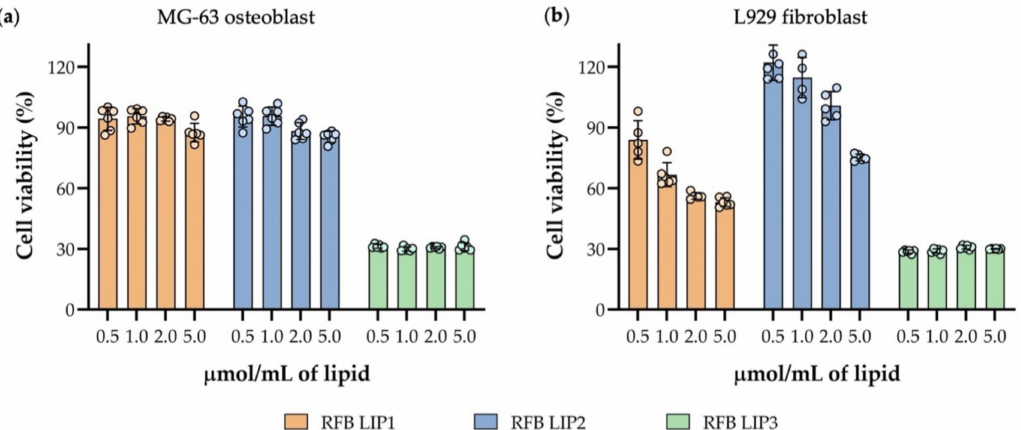
Figure 6. Cell viability of ( a ) human MG-63 osteoblast and ( b ) mouse L929 fibroblast cell lines 24 h after incubation with RFB-loaded liposomes (RFB LIP1, RFB LIP2 and RFB LIP3), at a lipid concentration of 0.5, 1.0, 2.0 and 5.0 µ mol/mL. Cell viability was determined by MTT reduction assay. Results are expressed as mean ± SD of at least two independent